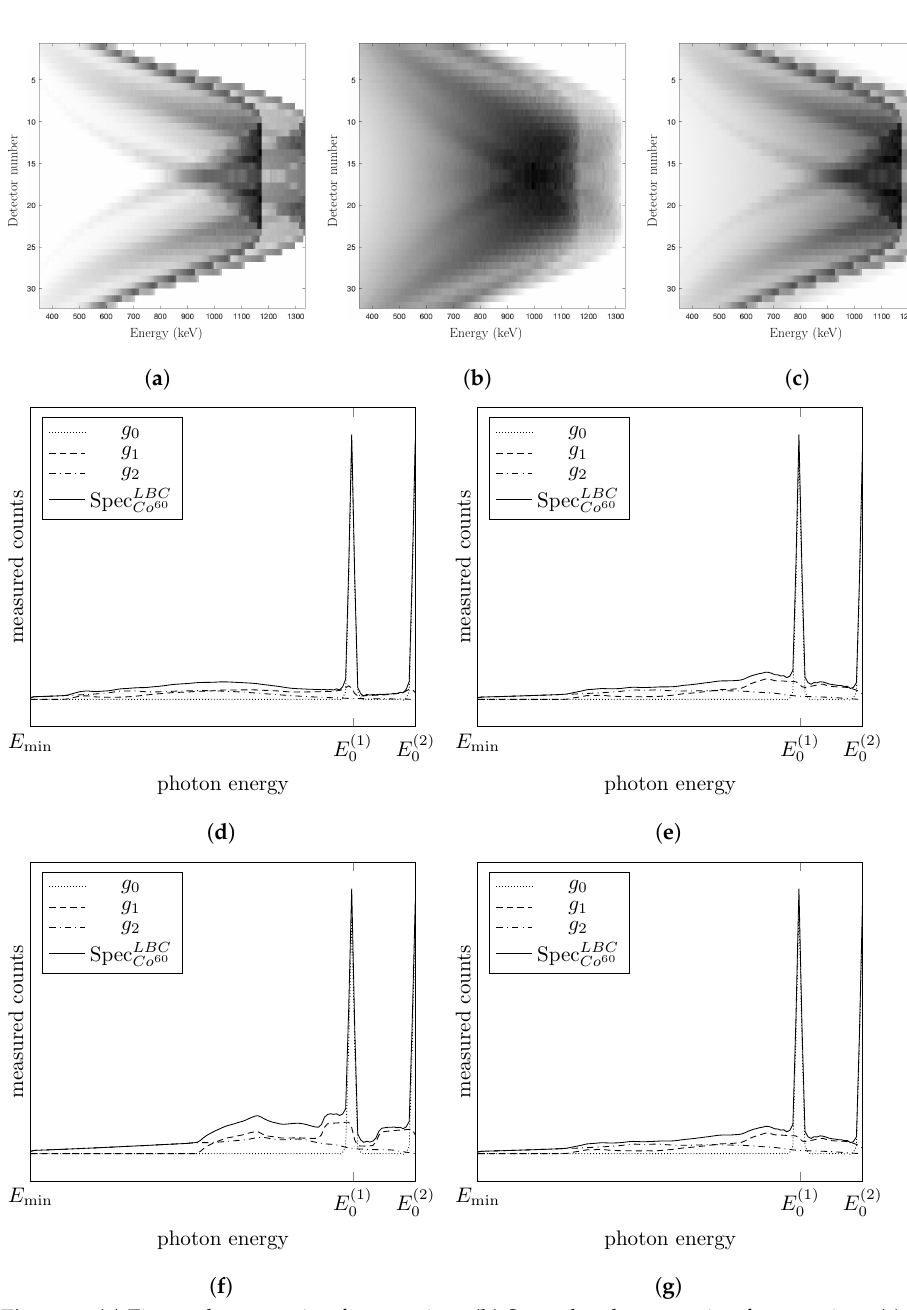
Figure 8. ( a ) First-order scattering for one view; ( b ) Second-order scattering for one view; ( c ) Comp- ton spectrum for one view. ( d – g ) depict the profiles for detector position d 1 , d 2 , d 3 , d 4 respectively. In order to emphasize the general reconstruction strategy described in Section